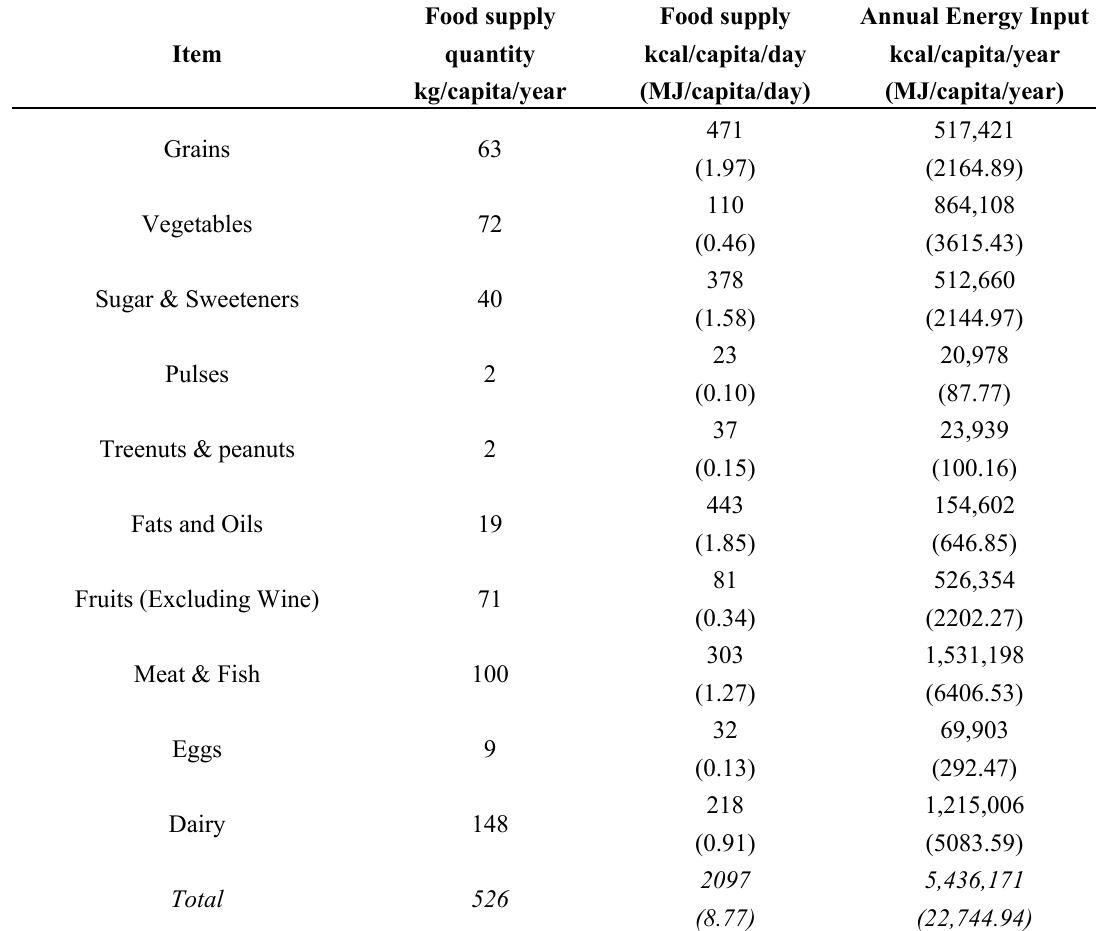
Table 4. Food supply and energy input for a typical American diet (2100 kcal or 8.79